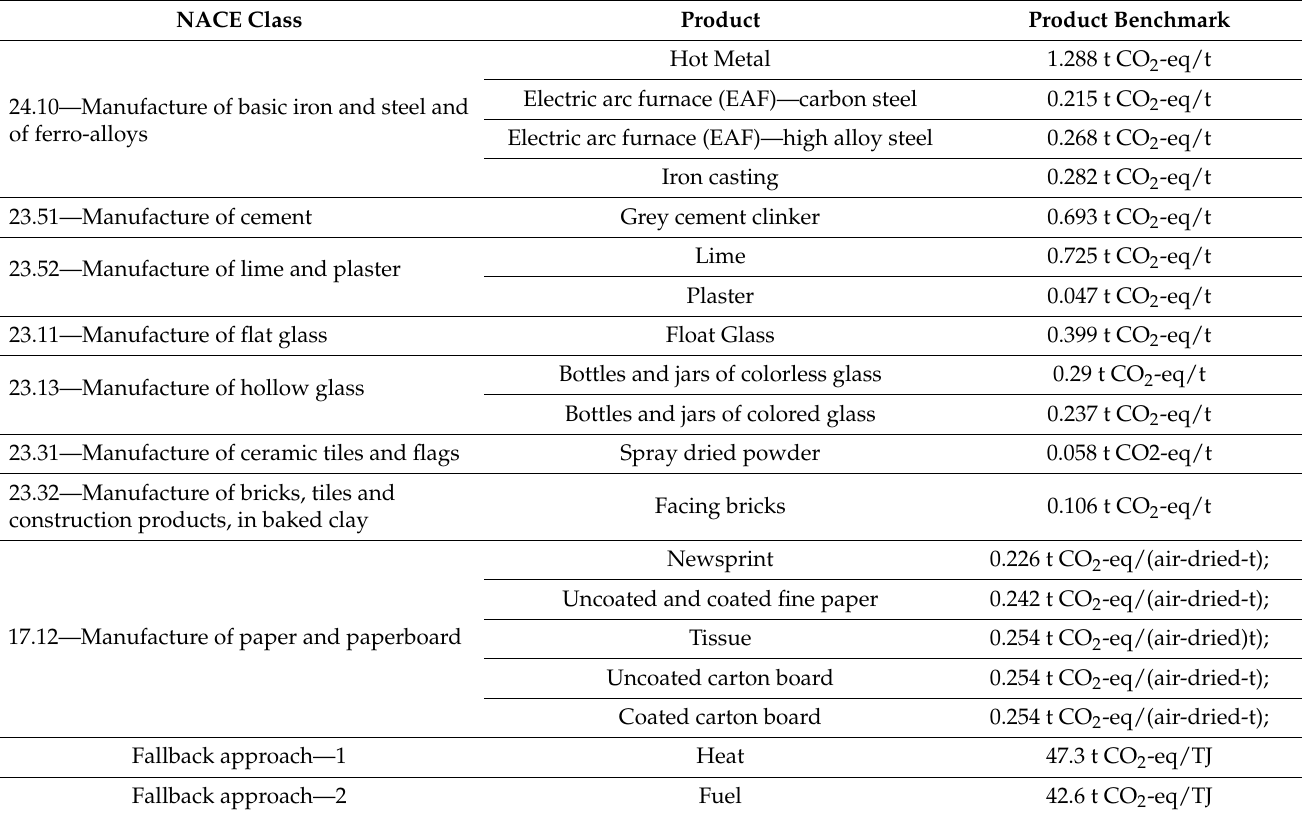
Table 3. Product benchmarks values as in EU Commission—Directorate General Climate Action, Update of benchmark values for the years 2021–2025 of phase 4 of the EU ETS—Benchmark curves and key parameters, updated final version issued on 12 October